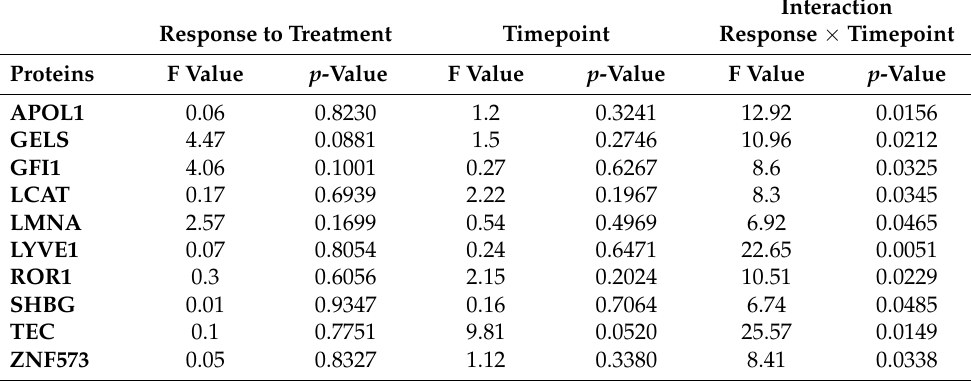
Table 2. Proteins selected from those differentially expressed in Table S4 and ANOVA statistic for time and